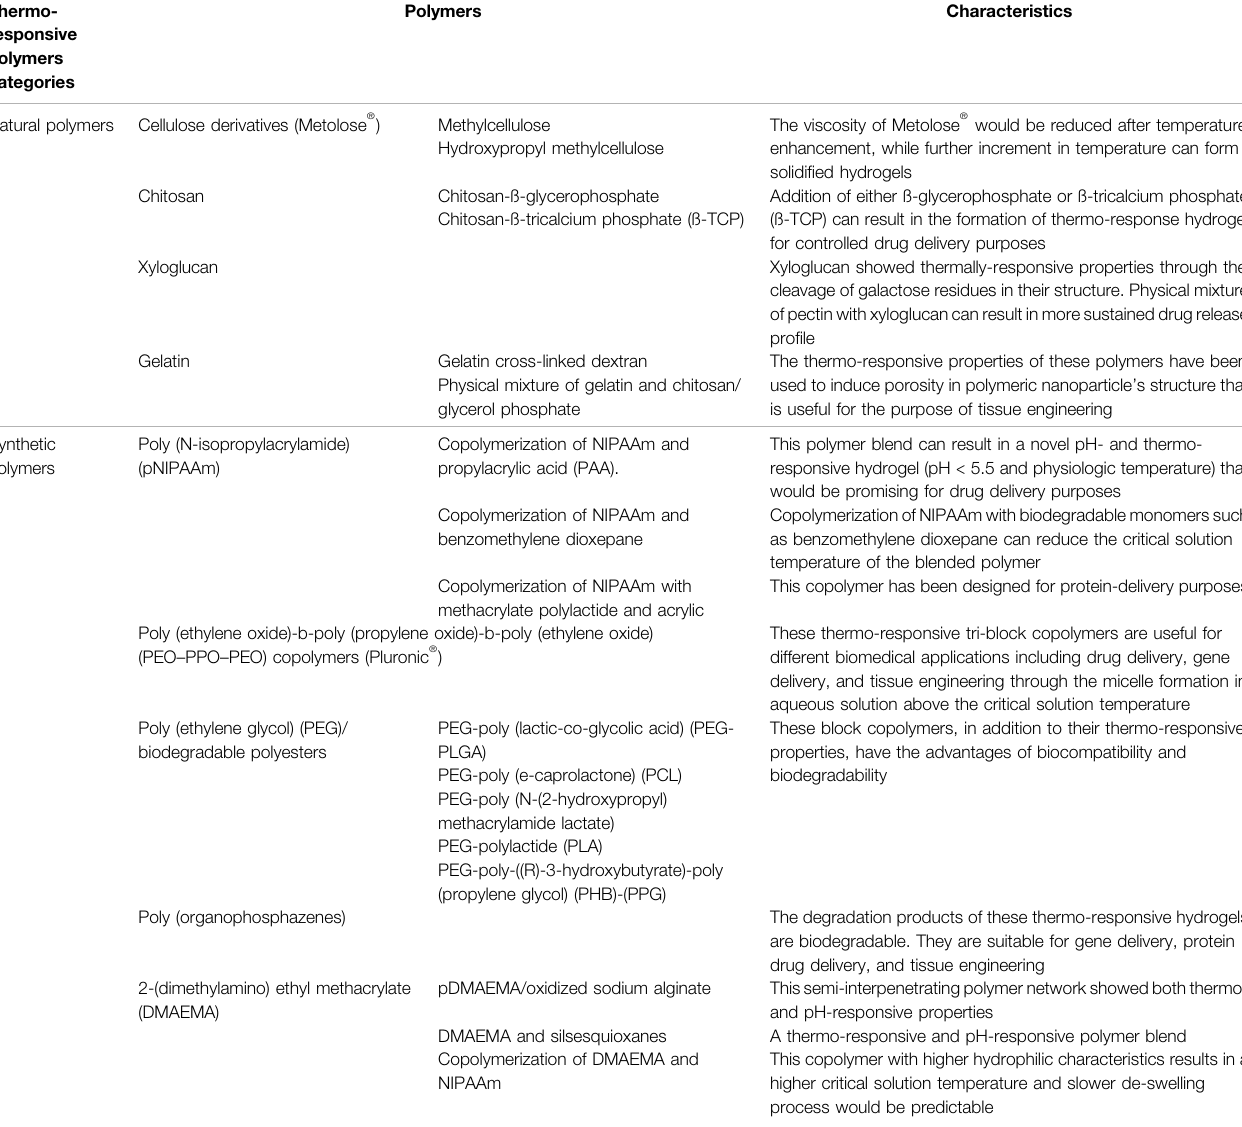
TABLE 2 | Different categories of thermo-responsive polymers and